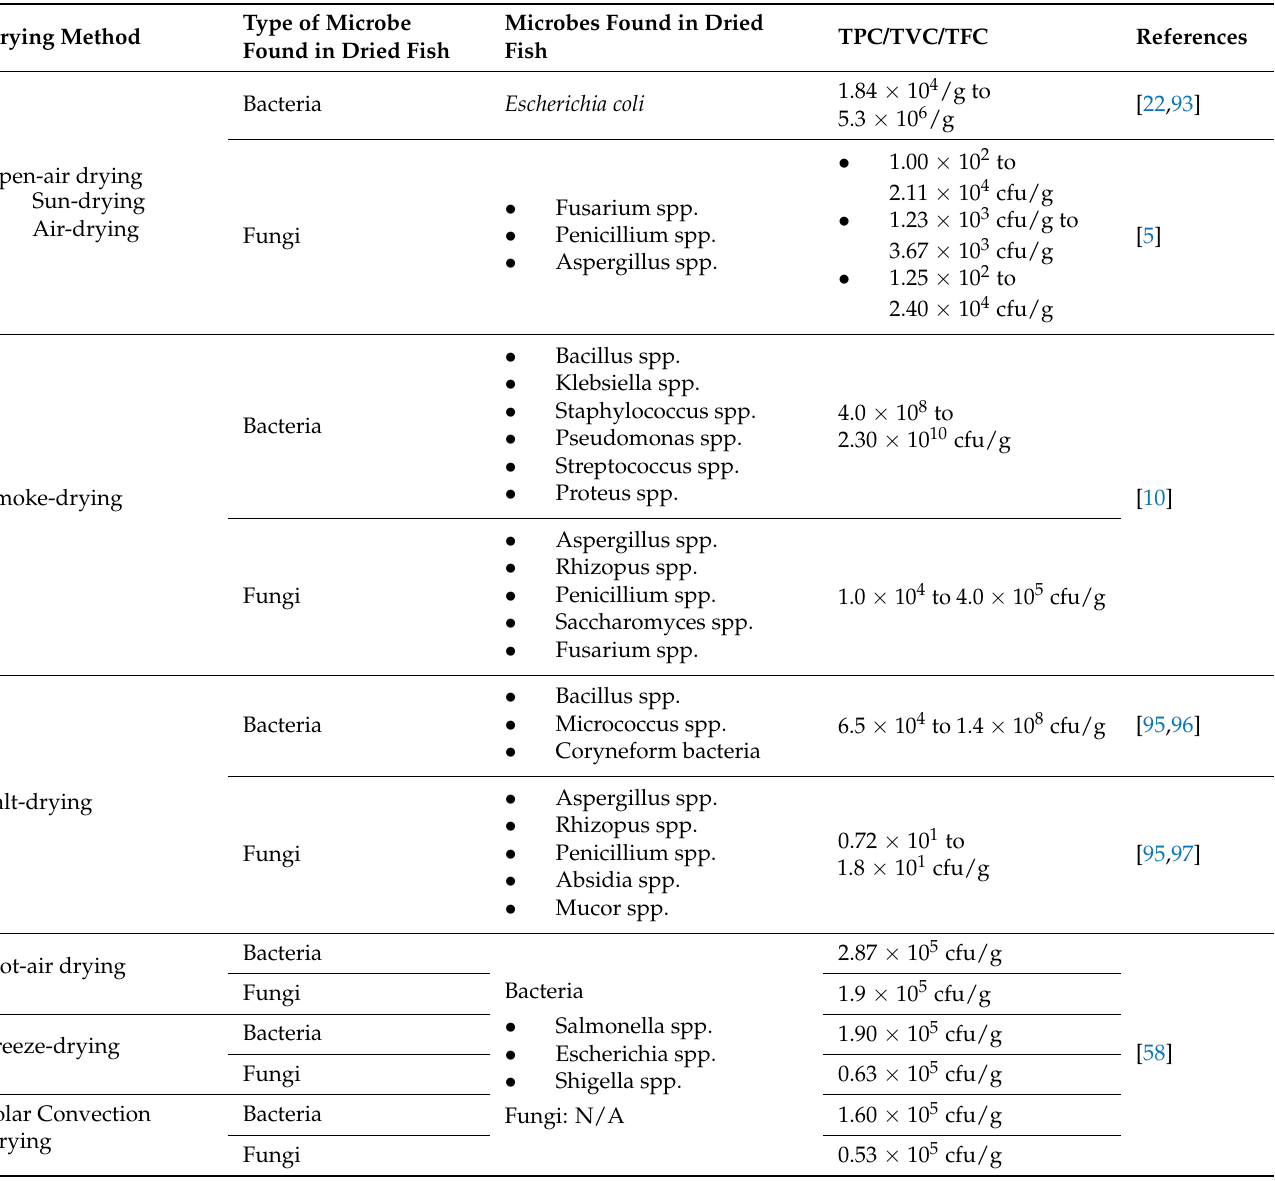
Table 3. Microbes found in dried fish along with their quantities according to their drying